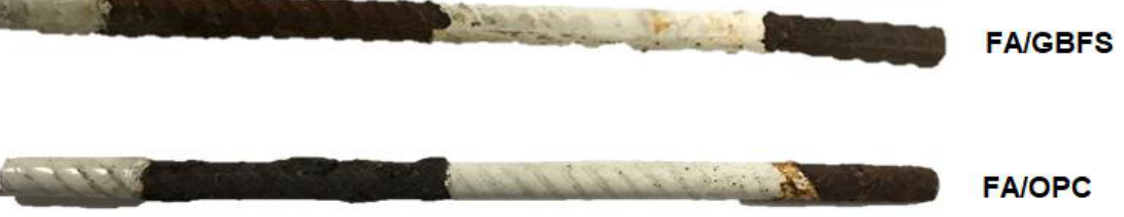
Figure 8. Rebar bars recovered after accelerated corrosion tests.